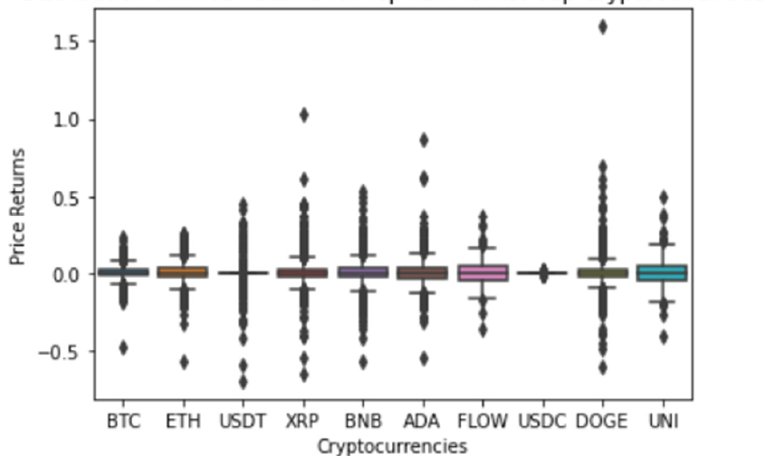
Figure 1. Boxplot of 10 cryptocurrencies based on market cap. Figure 2 visualizes each of the cryptocurrency price log returns over time. This allows us to understand the volatility of the cryptocurrencies. The cryptocurrency price log returns are shown to be volatile due to their frequent fluctuations over time. The cryptocurrency price log returns show a similar pattern of hitting at least one all-time high or low. FLOW is the only cryptocurrency that has a date value of just 2021. When looking at how the log returns of FLOW compare to the log returns of other cryptocurrencies in the predictions, the lack of data may affect the performances of models predicting cryptocurrencies’ price log returns.